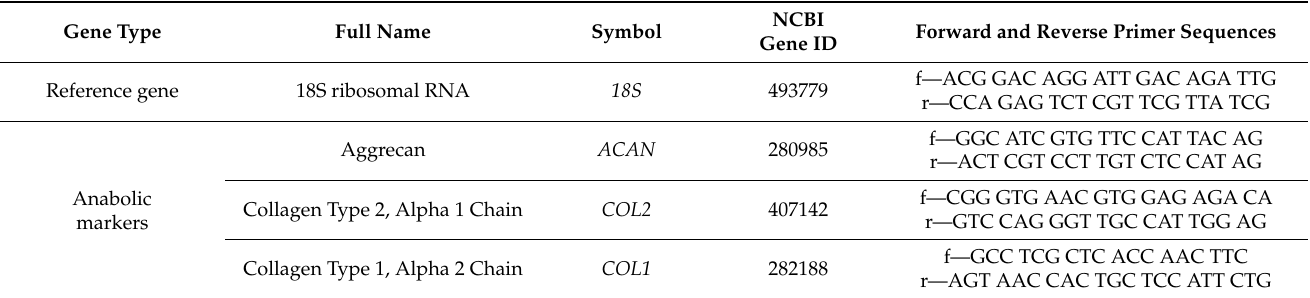
Table 1. Overview of the genes of interest and the primers used for qPCR in this